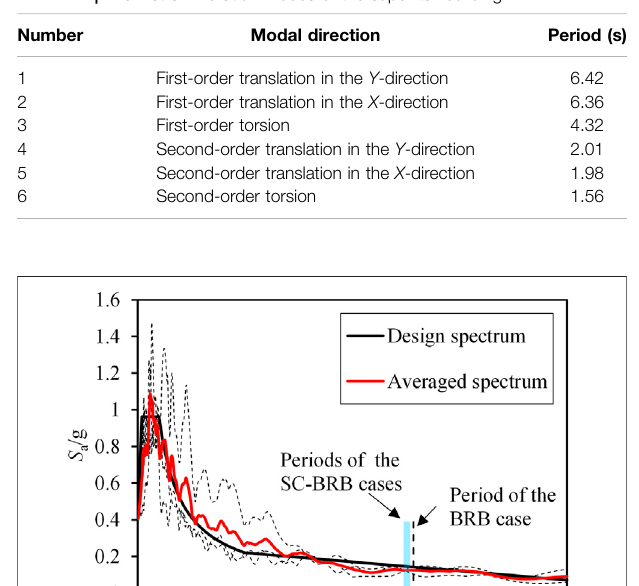
TABLE 2 | The fi rst six vibration modes of the super-tall building.